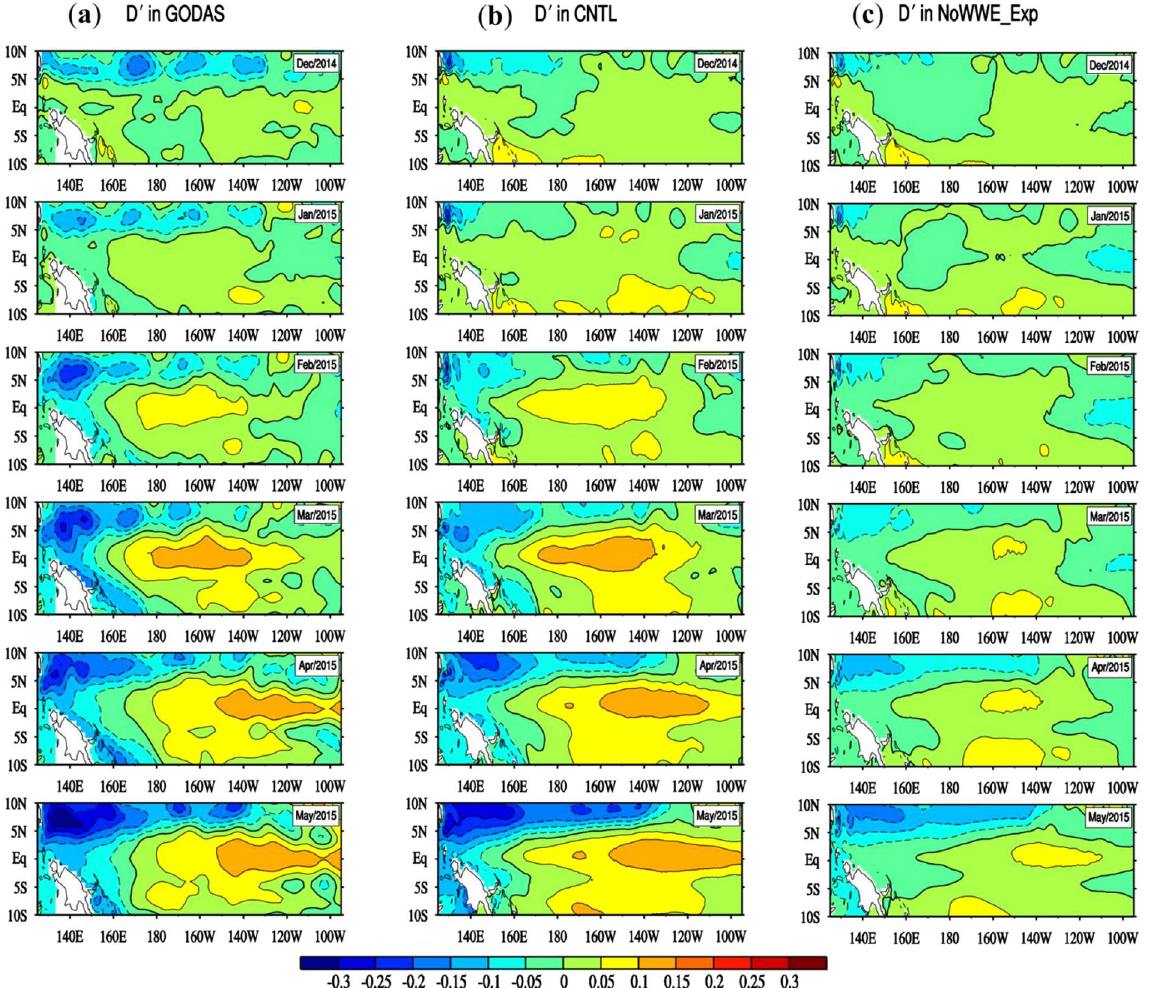
Figure 4. Month-to-month evolution of the sea surface height anomaly (unit: m; SSH ′ ; a proxy of D ′ )